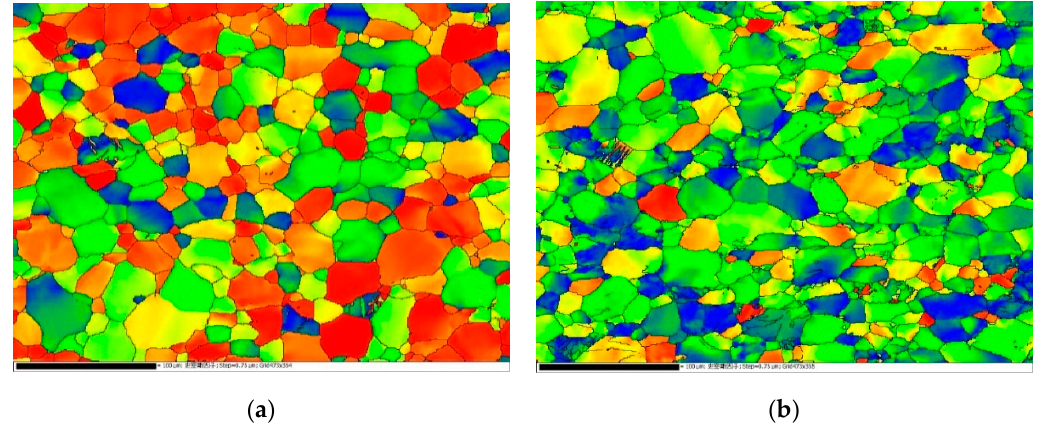
Figure 4. Electron backscatter diffraction (EBSD) maps of samples tested at ( a ) 0.001 s − 1 and ( b ) 1050 s − 1 .